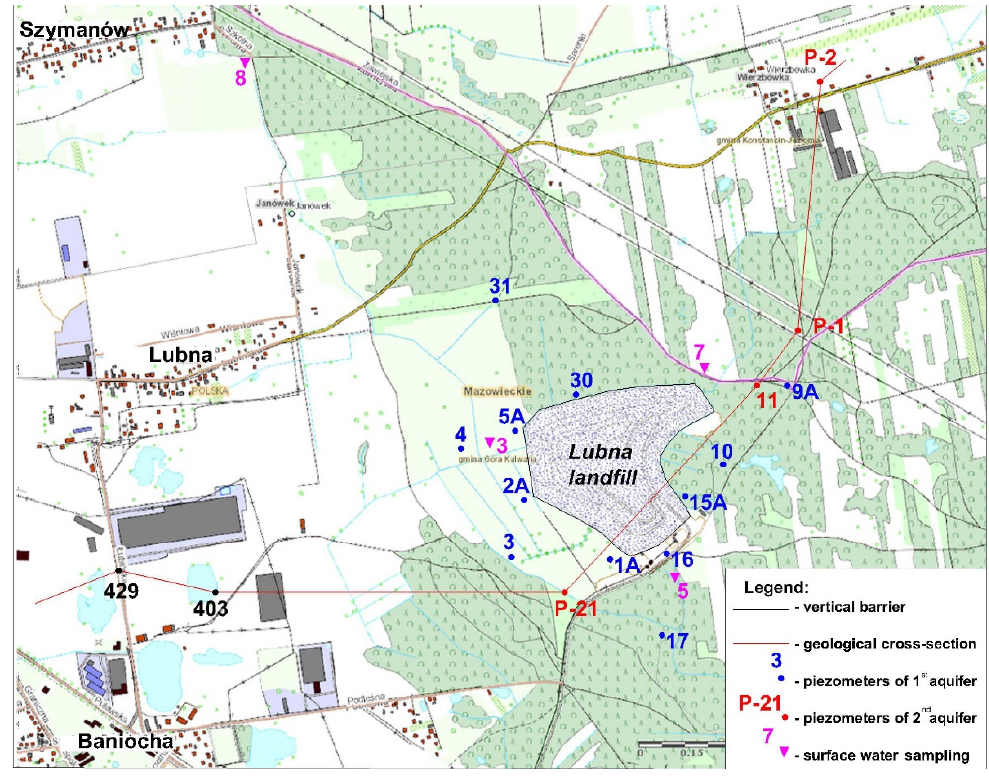
Figure 3. Groundwater monitoring for Lubna Landfill, with geological cross-section.